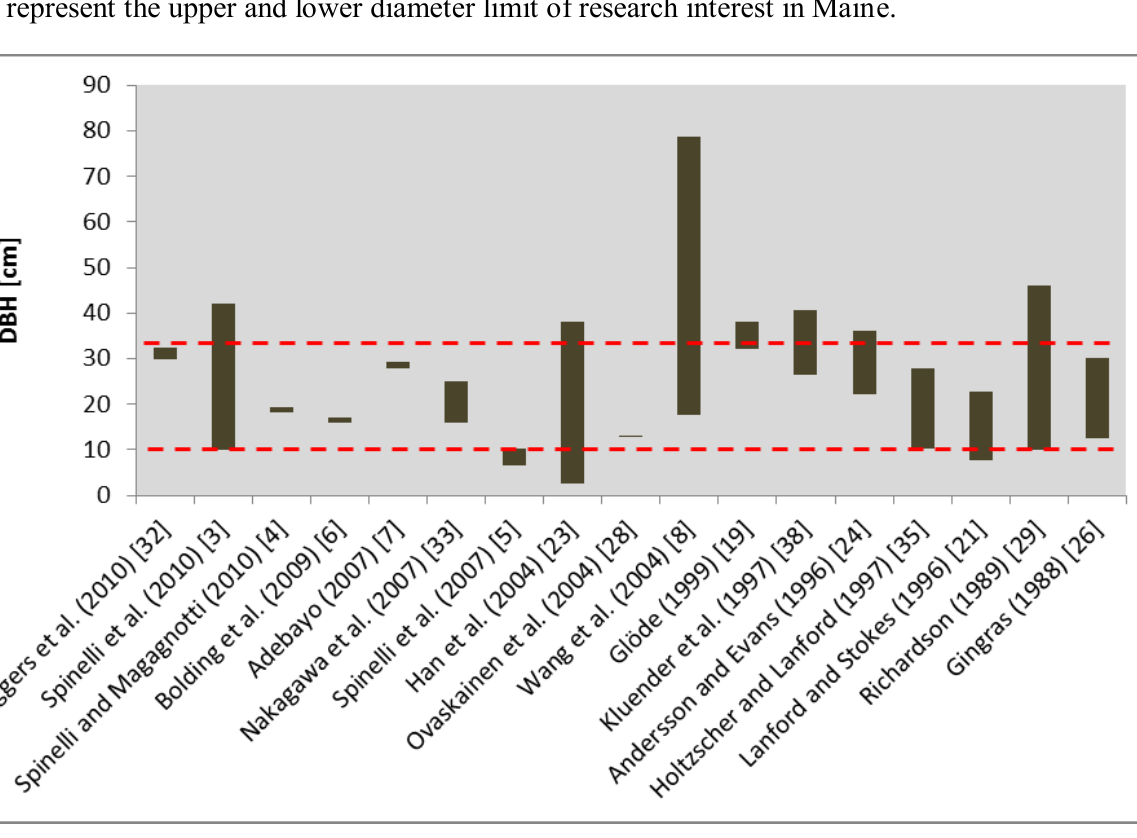
Figure 2. Range of dbh in harvesting equipment productivity studies. Dashed lines represent the upper and lower diameter limit of research interest in